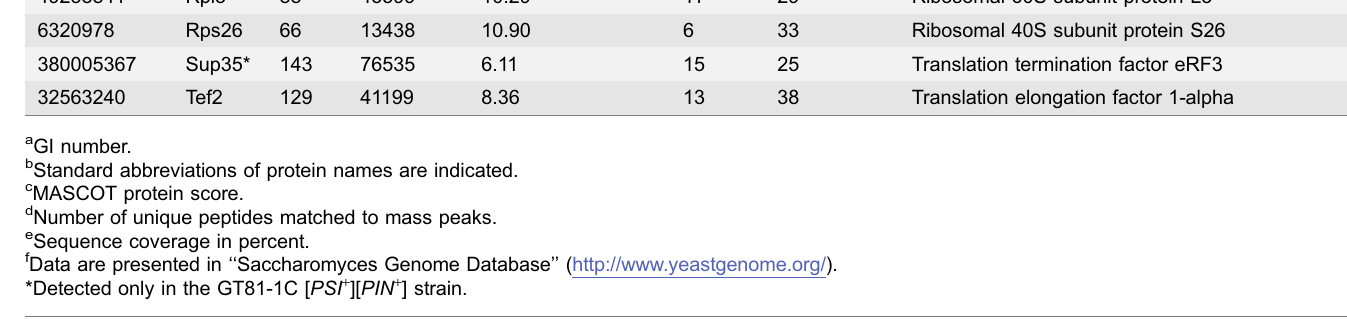
Table 4. Identification of UTC-insoluble proteins in DRAFs isolated using sarkosyl from the GT81-1C [ PSI + ][ PIN + ] strain and its [ psi 2 ][ pin 2 ] derivative. Accession a